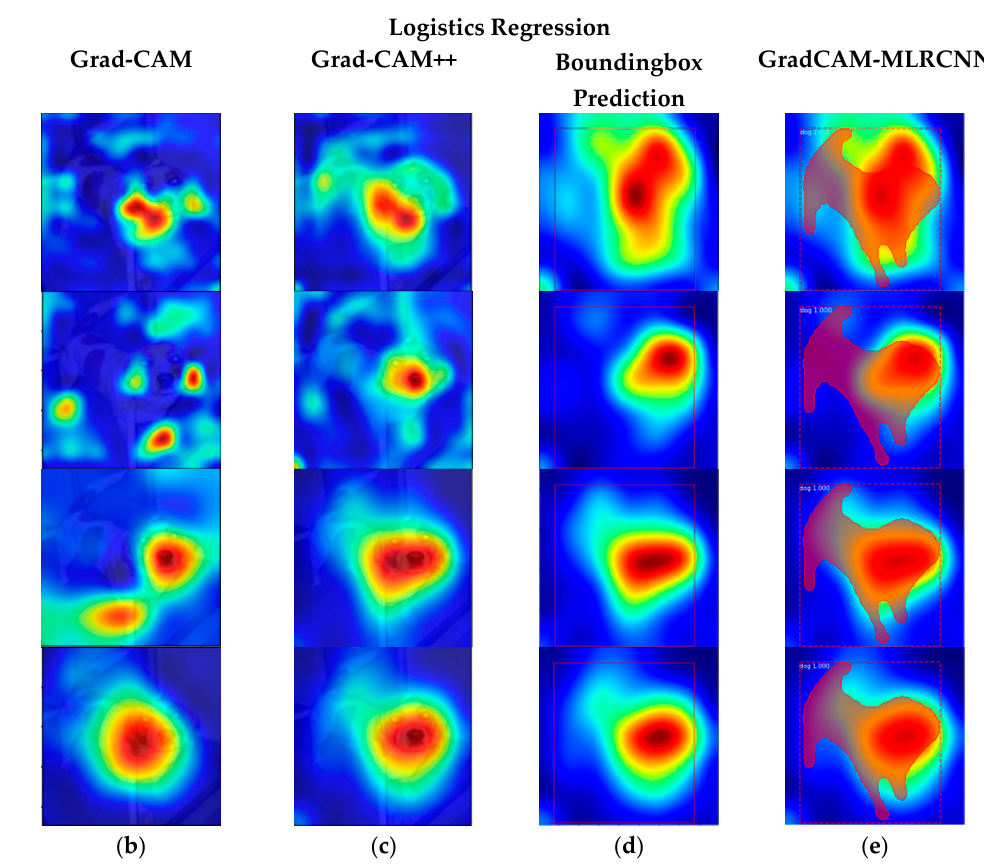
Figure 3. ( a ) Various pre-trained models; ( b ) results of Grad-CAM; ( c ) results of Grad-CAM++; ( d ) bounding box prediction on Grad-CAM++; and ( e ) GradCAM-MLRCNN.